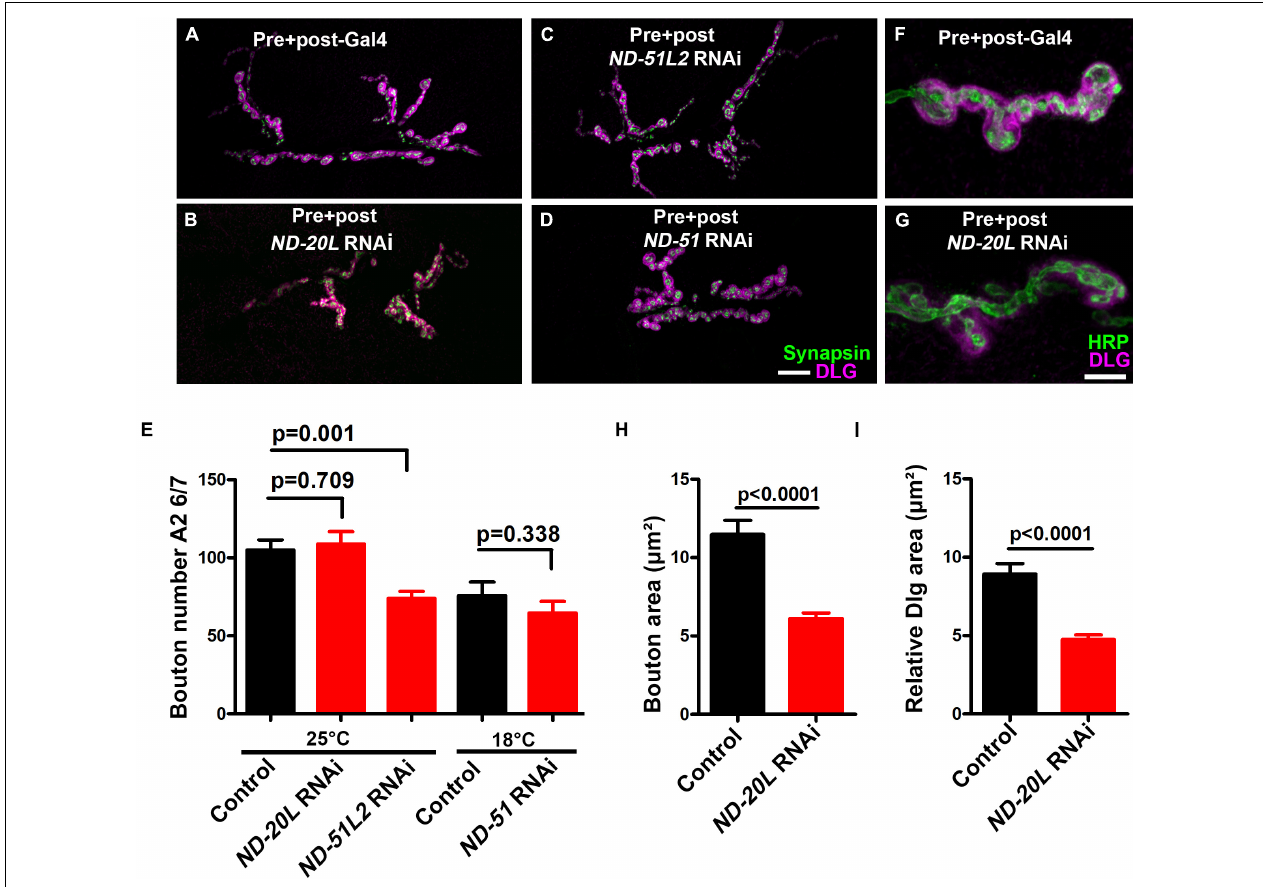
FIGURE 6 | Drosophila Mitochondrial Complex I subunits are required for normal neuromuscular junction (NMJ) morphology. (A–D) Representative confocal images of NMJ synapses at muscle 6/7 of (A) Pre + post-Gal4 control, Pre + post-Gal4 driven (B) ND-20L[RNAi] , (C) ND-51L2 RNAi and (D) ND-51 RNAi flies double immunolabeled with discs large (DLG) (magenta) and synapsin (green) antibodies. The NMJ morphological defects were observed in the indicated genotypes. The flies were reared at 25 ◦ C. The knockdown of ND-51 RNAi was lethal in the third instar larval stage at 25 ◦ C and 29 ◦ C. Hence we have conducted this experiment at 18 ◦ C with respective control. Scale bar: 10 µ m. (E) Histograms showing the average total number of boutons at muscle 6/7 of A2 hemisegment in Pre + post-Gal4 control (105.0 ± 6.38), Pre + post-Gal4 driven ND-20L[RNAi] (108.9 ± 8.01), ND-51L2 RNAi (73.88 ± 4.50), control (75.86 ± 8.57) and ND-51 RNAi (64.63 ± 7.46) larvae. (F,G) Confocal images of boutons at third instar larval NMJ synapse in (F) Pre + post-Gal4 control and (G) Pre + post-Gal4 driven ND-20L[RNAi] double immunolabeled with DLG (magenta) and HRP (green) antibodies. Note that the gross morphology of SSR and the immunoreactivity of DLG were reduced in ND-20L[RNAi] compared to control. (H,I) Histograms showing average bouton area (H) relative DLG area (I) in µ m 2 of Pre + post-Gal4 control (bouton area: 11.49 ± 0.88, relative DLG area: 8.93 ± 0.65), Pre + post-Gal4 driven ND-20L[RNAi] bouton area: (6.12 ± 0.34, relative DLG area: 4.74 ± 0.29) larvae. Scale bar represents 10 µ m. At least 35 boutons of muscle 6/7 of A2 hemisegment from 4 animals (8 NMJs) were used for area quantification. Statistical analysis based on Student’s t -test for pairwise comparison and one-way ANOVA with Tukey’s post hoc test for multiple comparisons. Error bars represent mean ± s.e.m. p -values are indicated in the